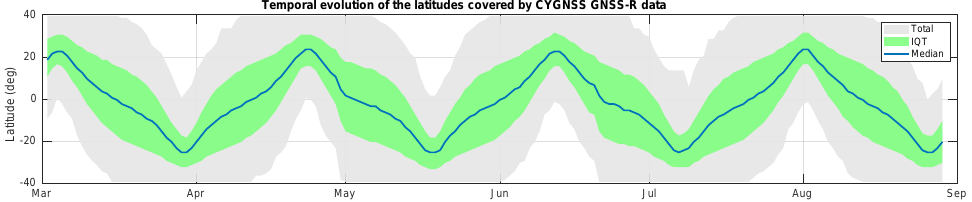
Figure 2. Temporal evolution of the region under study after applying the filters (LT and quality), and the detrending described in this section. The graph shows the latitudes covered at least by one pixel (gray), and the interquartile (green), and median (blue line) of these latitudes. The average period of this evolution is 50 days.